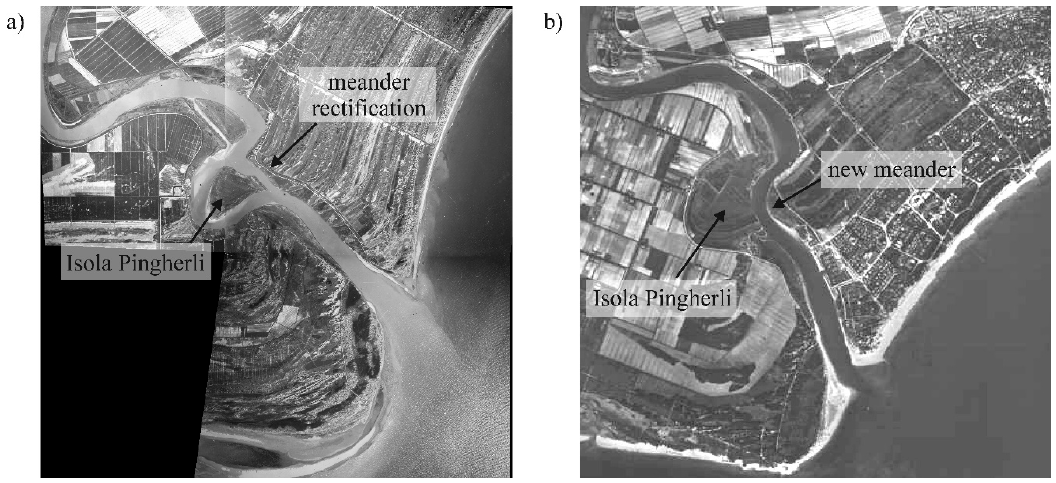
Figure 4. Meander rectification: ( a ) first realization of the straightening (1929); and ( b ) beginning of the formation of the new meander (1988).